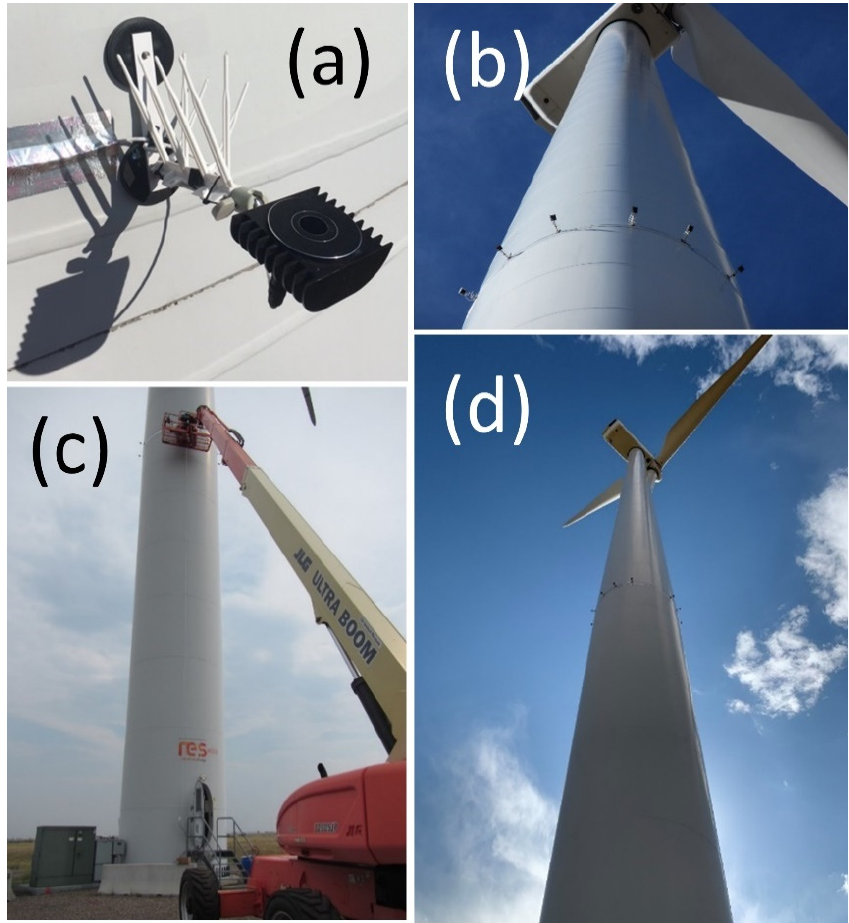
Figure 2. UV illuminator units ( a ) magnetically attached around the circumference of wind turbine tower in an array of 12 ( b ) and installed 20 m above the ground with a boom truck ( c ). Light arrays were positioned below the sweep of the wind turbine blades and one-quarter of the way up the turbine monopole ( d ) so they lit the blades, upper monopole, and underside of the nacelle. Images by Paul Cryan.